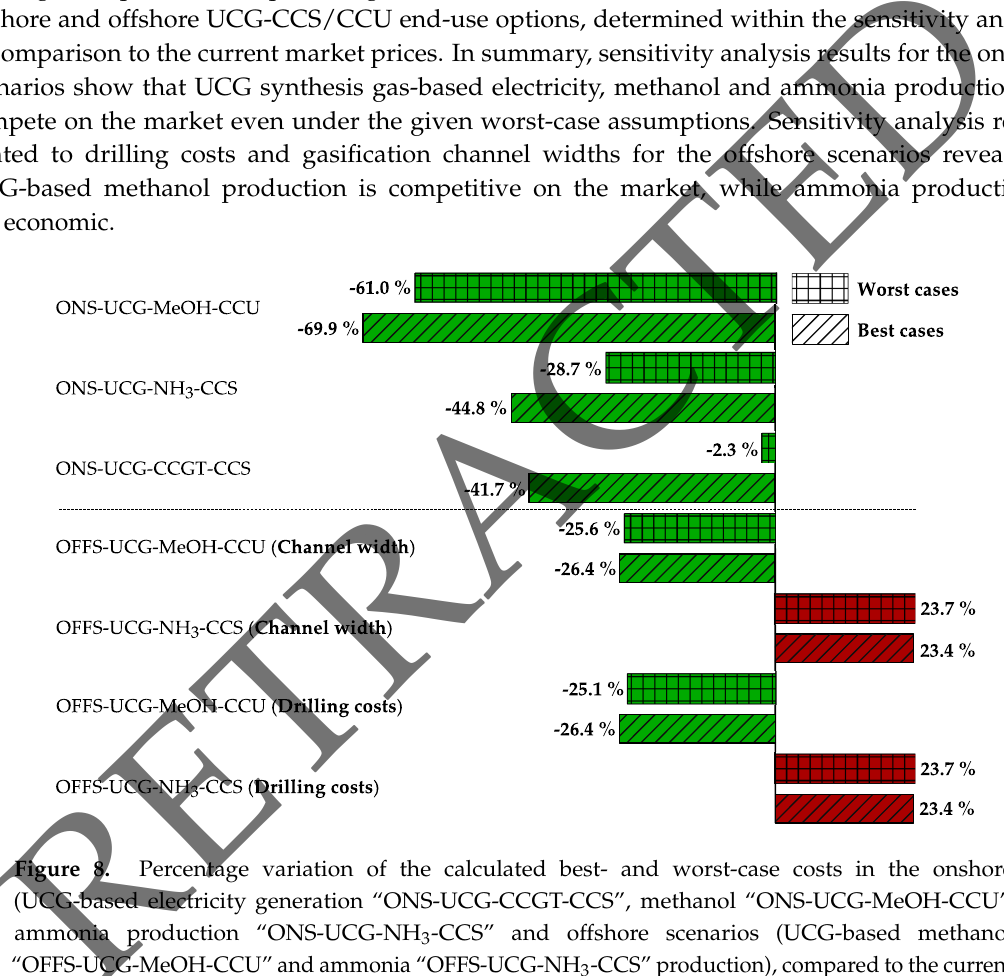
Figure 8. Percentage variation of the calculated best- and worst-case costs in the onshore (UCG-based electricity generation “ONS-UCG-CCGT-CCS”, methanol “ONS-UCG-MeOH-CCU”, ammonia production “ONS-UCG-NH 3 -CCS” and offshore scenarios (UCG-based methanol “OFFS-UCG-MeOH-CCU” and ammonia “OFFS-UCG-NH 3 -CCS” production), compared to the current market